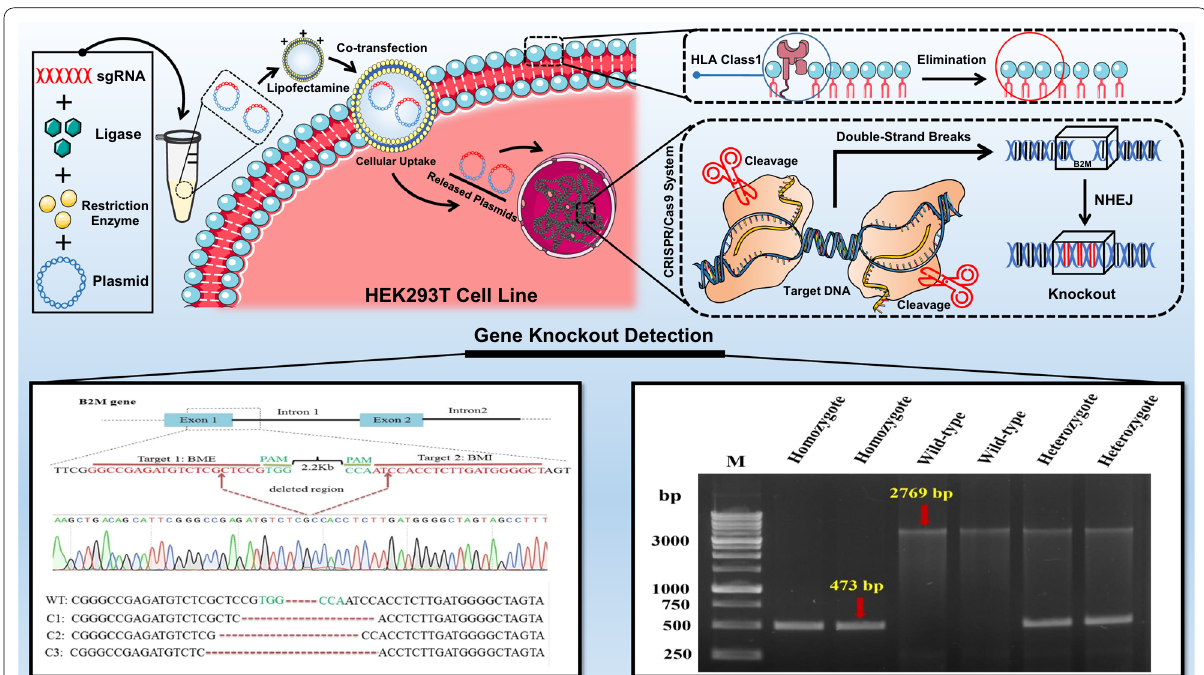
Fig. 1 A summary of B2M gene knockout as covered in this study indicates the process, which would ultimately lead to gene knockout by CRISPR/ Cas9 system. Analysis of the gene deletion via PCR and Sanger sequencing confirms approximately 2.2 bp segment deletion separating the two guide RNAs. Indels in targeted segment is slightly variable between different single clones due the incomplete Cas9 cleavage